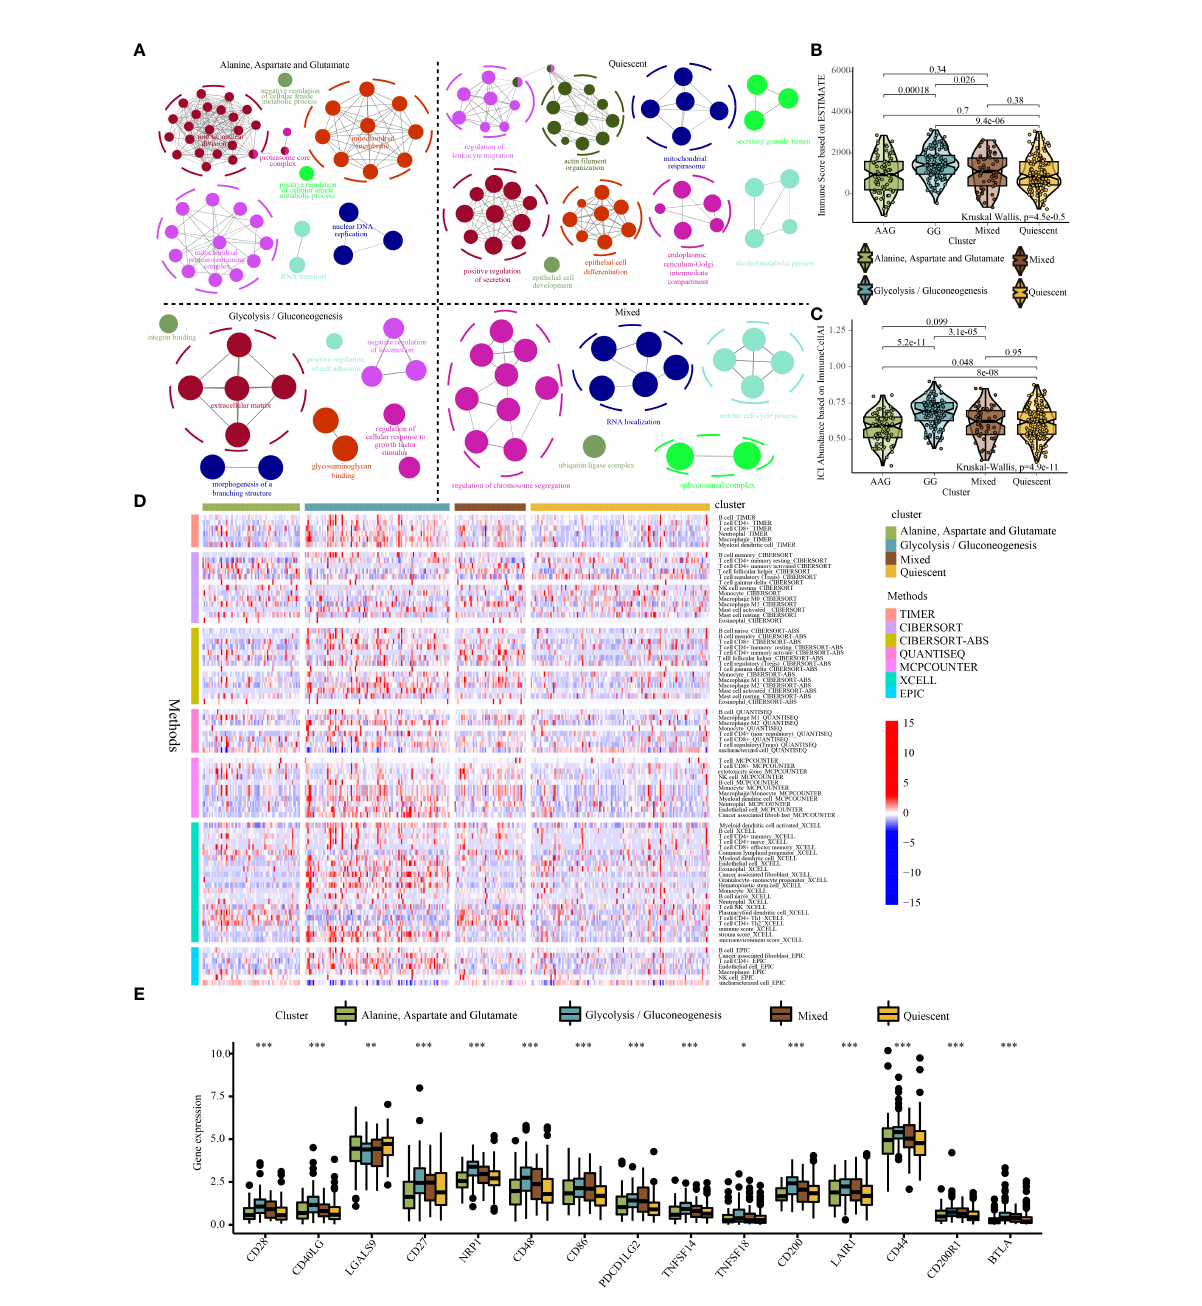
FIGURE 5 Systematic analysis of the speci fi c molecule functions and tumour immune microenvironment across different metabolic subtypes. (A) Functional annotation of speci fi c molecules of the alanine – aspartate – glutamate, glycolysis/gluconeogenesis, quiescent, and mixed subtypes. (B) Violin plot demonstrating immune scores of the four metabolic subtypes evaluated using the ESTIMATE algorithm. (C) Violin plot demonstrating the abundance of immune cell in fi ltration among the four metabolic subtypes evaluated using the ImmuneCellAI algorithm. (D) The distribution of immune cell in fi ltration among the four metabolic subtypes based on the TIMER, CIBERSOFT, QUANTISEQ, MCPCOUNTER, XCELL and EPIC algorithms (Note: Only immune cells with p < 0.05 were displayed in the heatmap). (E) Expression of immune checkpoint genes among the four metabolic subtypes. * indicates p <0.05; ** indicates p < 0.01; *** indicates p <